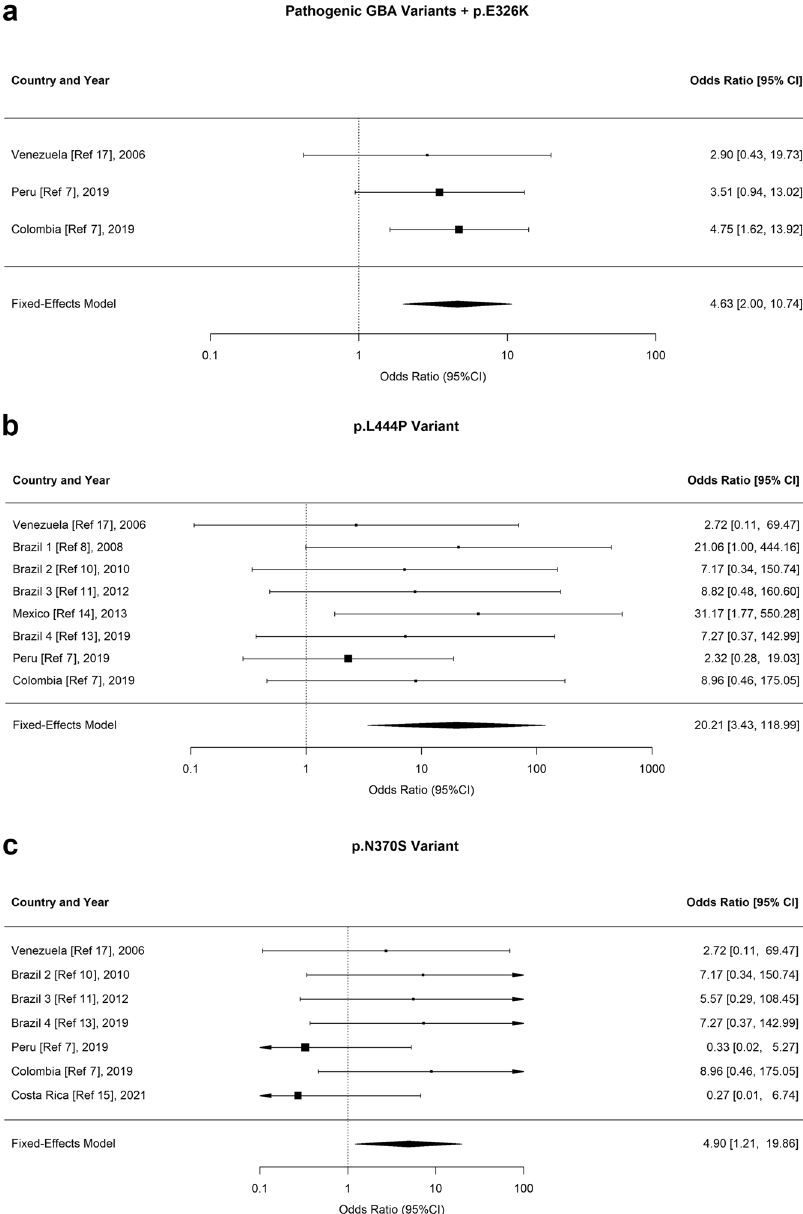
Fig. 1 Meta-analyses of GBA1 variants in patients with Parkinson ’ s disease from Latin America. a Meta-analysis of combined GBA1 pathogenic variants plus p.E326K from studies which performed full sequencing of the gene. b Meta-analysis of the GBA1 L444P variant. c Meta-analysis of the GBA1 N370S